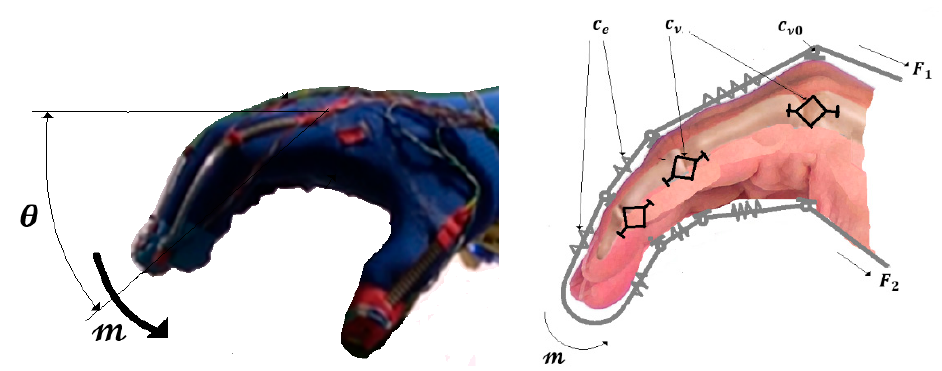
Figure 1. Exoskeleton Glove and its biomechanical components.